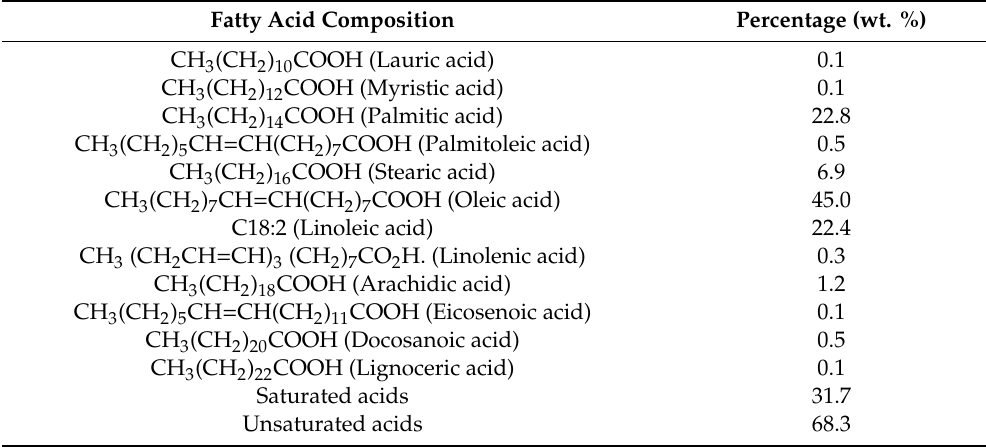
Table 1. The fatty acid composition of crude C. manghas oil